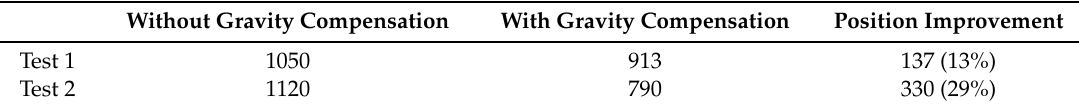
Table 5. The maximum value of position error (m) compared with the GPS result.